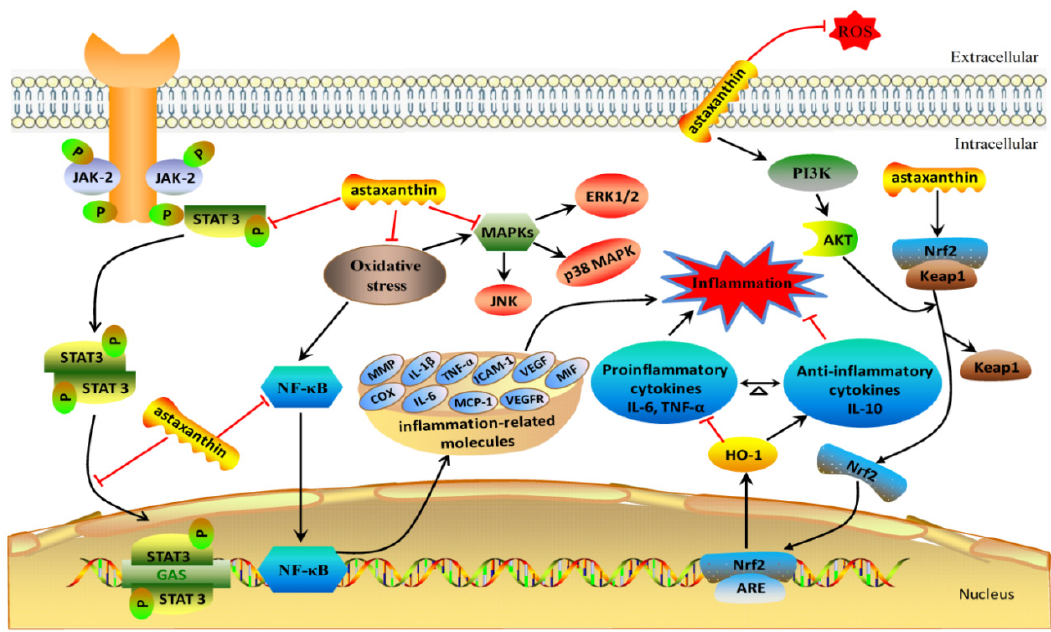
Figure 2. The anti-inflammation mechanisms of astaxanthin. Inflammatory biomarkers, such as many acute phase proteins (APPs), inducible enzymes, chemokines and cytokines, are target genes regulated by astaxanthin. In addition to inflammatory molecules, astaxanthin can promote PI3K / AkT and nuclear factor erythroid 2-like 2 (Nrf2) signaling pathways, but block NF- κ B, extracellular-signal-regulated kinase (ERK1 / 2), c-Jun N-terminal kinases (JNK), p38 MAPK, and JAK-2 / STAT-3 signaling pathways to attenuate inflammation. Red arrows indicate inhibitory action, and black arrows show enhancement action.